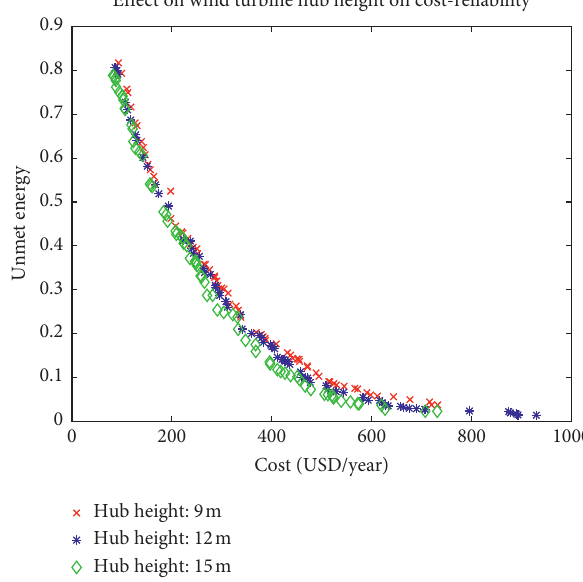
Figure 3: The effect of wind turbine height on cost-reliability relationships of a hybrid wind/solar energy system for a detached house of 5 people (PV panels tilt angle: 65 ° toward the south; battery type: Li-ion batteries; using measured weather data from Holt; yearly consumption: